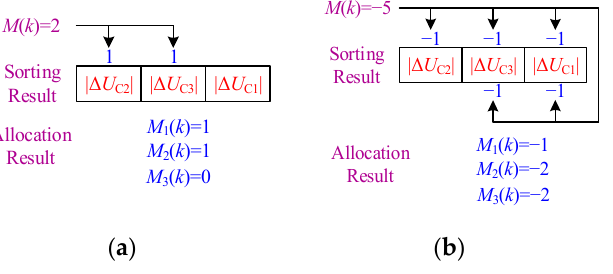
Figure 5. Output level allocation schematic: ( a ) M ( k ) = 2. ( b ) M ( k ) = − 5.